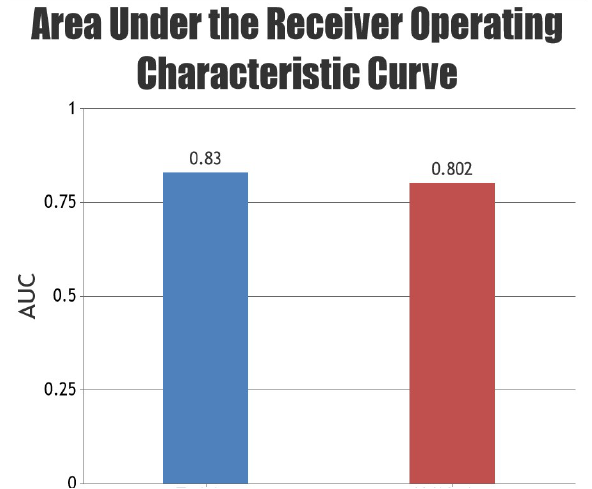
Figure 7. The visualization of AUC during